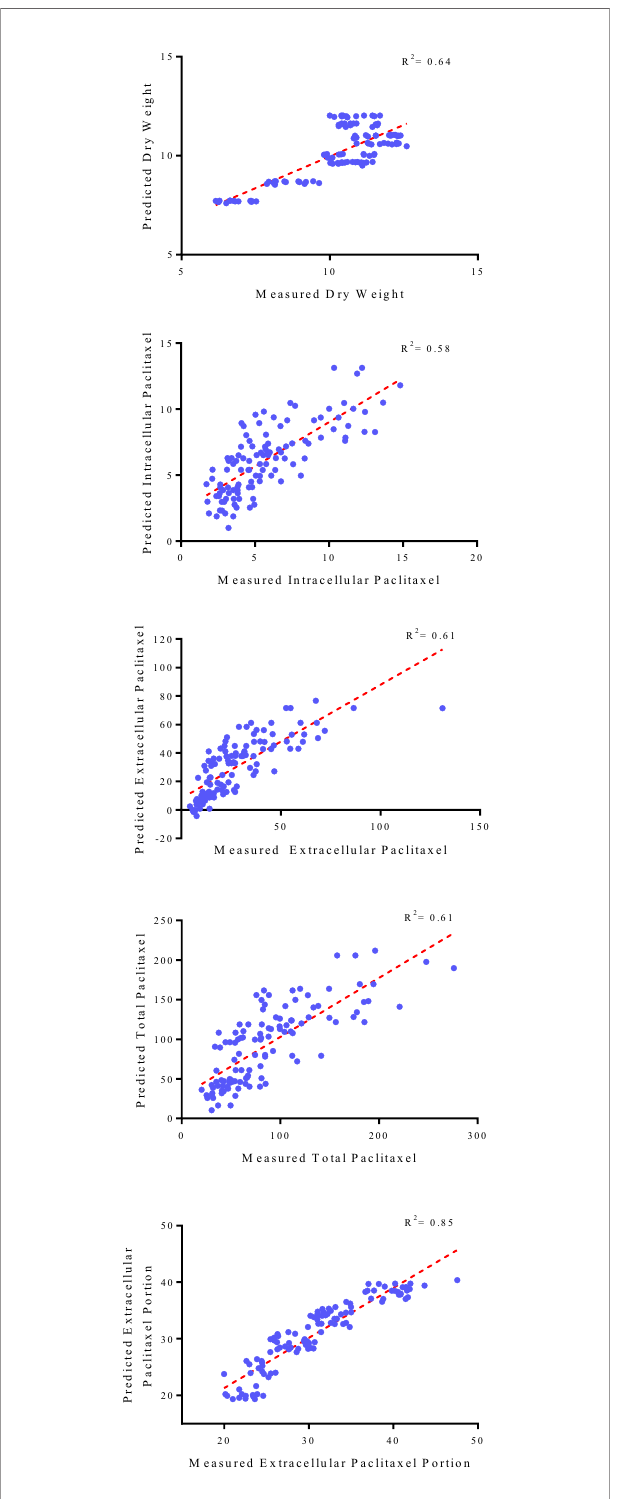
FIGURE 3 | Scatter plot of actual data against predicted values of dry weight, intracellular, extracellular and total yield of paclitaxel, and extracellular paclitaxel portion in Corylus avellana cell cultures using backward regression models in the testing subset. The solid line shows fi tted simple regression line on scatter